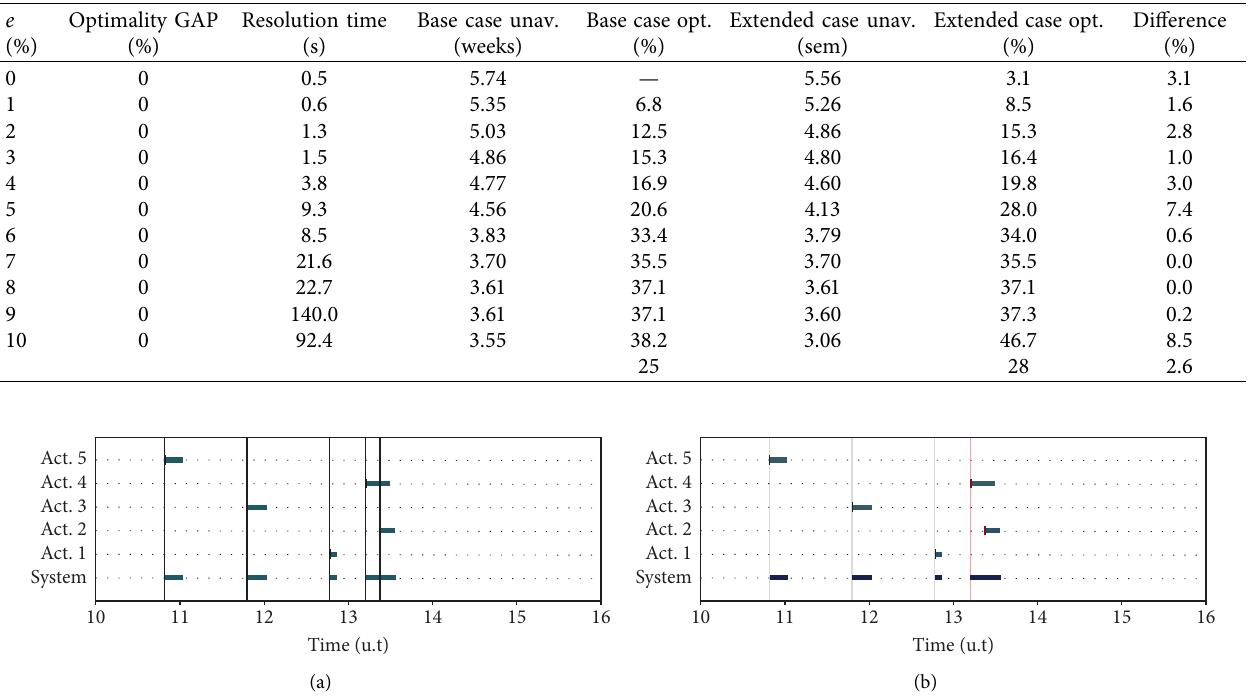
Table 3: Comparative results of total unavailability of the system for diferent tolerance scenarios between both models. e Optimality GAP (%)